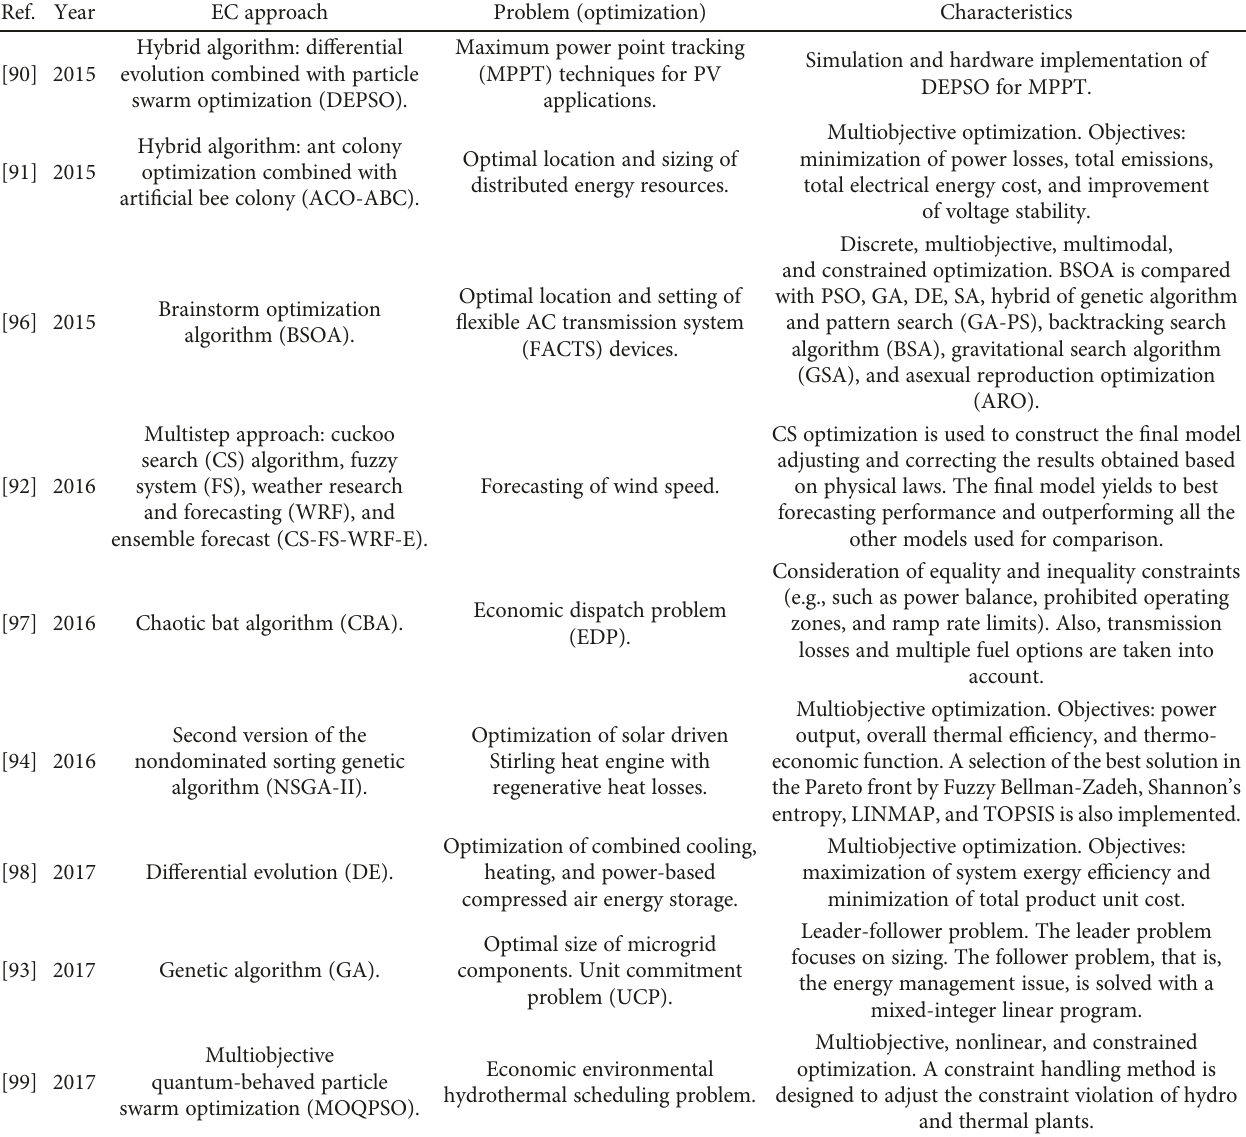
Table 5: Recent most cited papers of EC applied to energy-related problems. The three most cited papers from 2015, 2016, and 2017 are